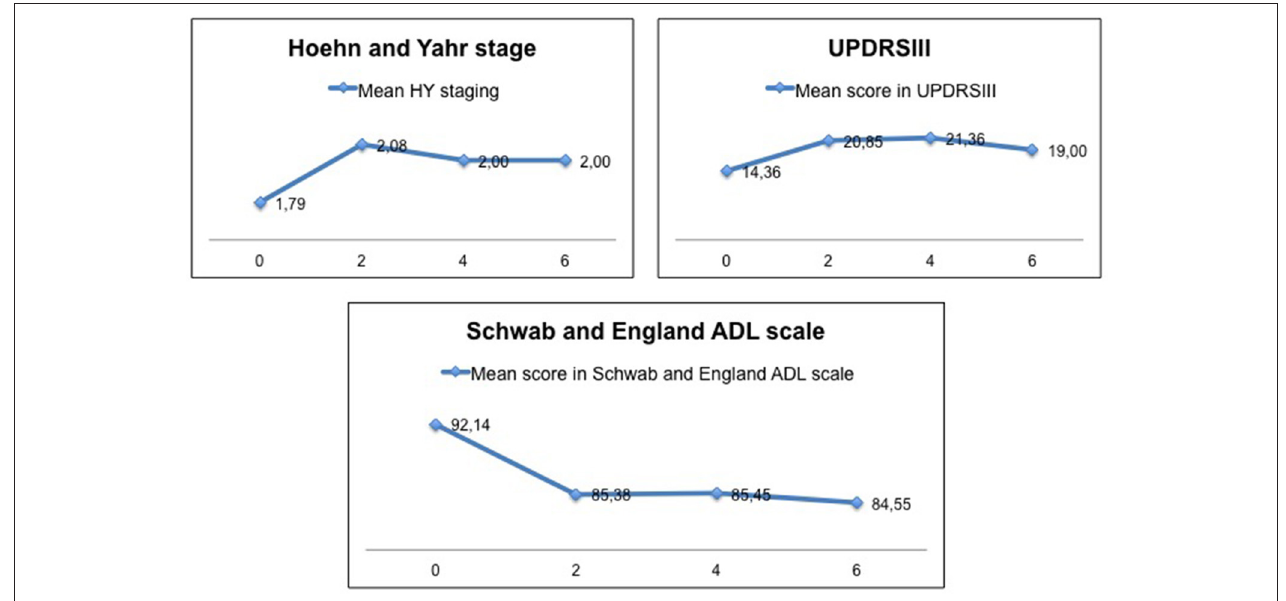
FIGURE 2 | Motor progression and its impact on activities of daily living in the subgroup of patients of our cohort participating in the